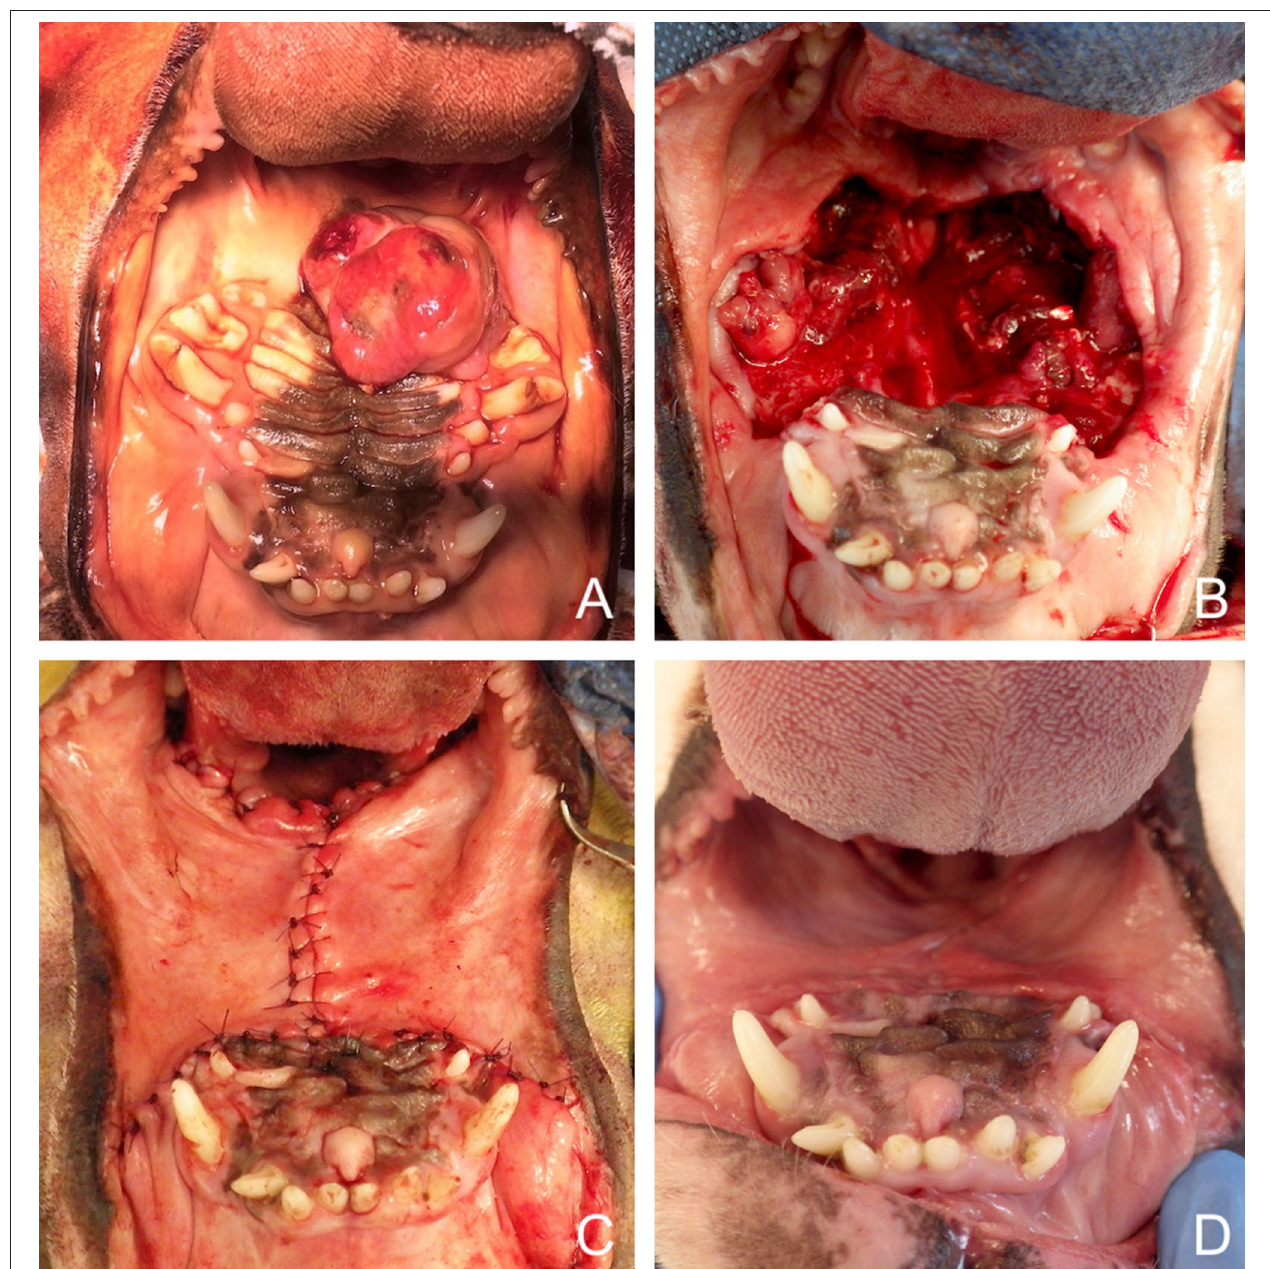
FIGURE 3 | Bilateral myomucosal advancement flaps for closure of a large central maxillary defect after removal of a multilobular tumour in a dog. (A) Preoperative aspect of the tumour. (B) Radical maxillectomy. (C) Immediate postoperative aspect. (D) 5-months postoperative aspect.